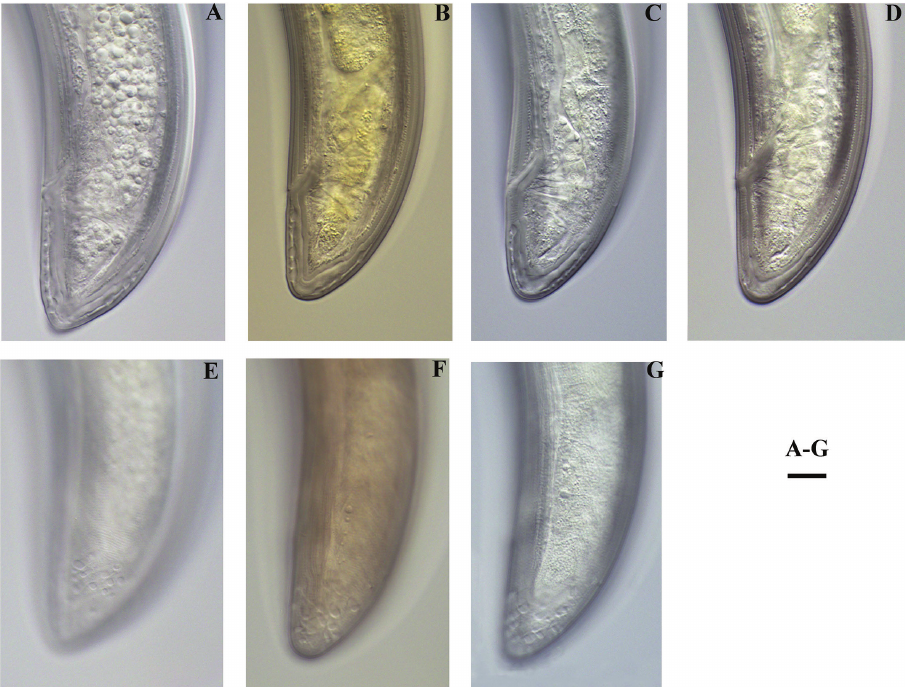
Figure 2. Enchodeloides signyensis (Loof, 1975), gen. n., comb. n. (= Enchodelus signyensis Loof, 1975). Fe- male : A–D Tail ends ( A specimen from King George Island; B, C, D specimens from Livingston Island) E–G Tail ends with saccate bodies ( E specimen from King George Island F, G specimens from Livingston Island). Scale bar: 10